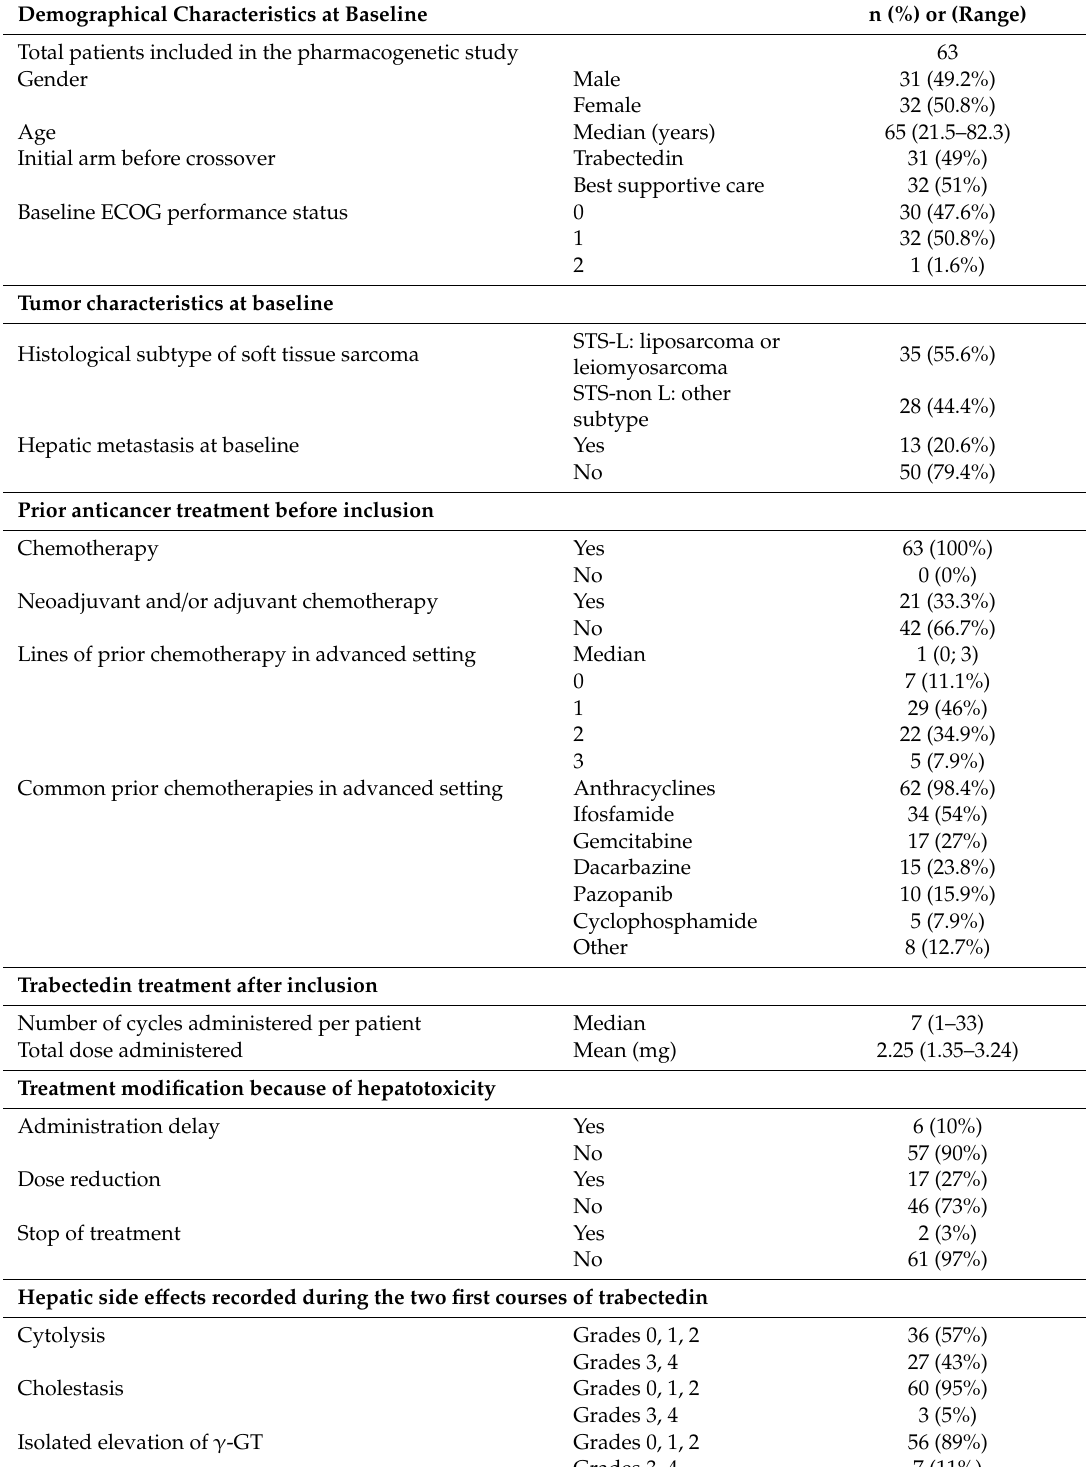
Table 1. Patient characteristics and toxicity